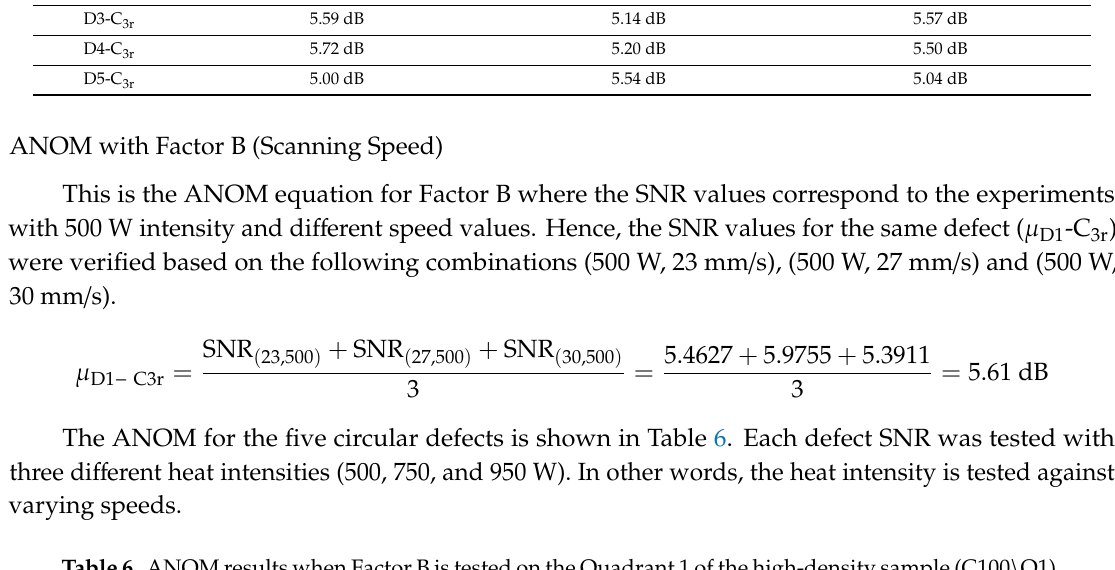
Table 6. ANOM results when Factor B is tested on the Quadrant 1 of the high-density sample (C100 \